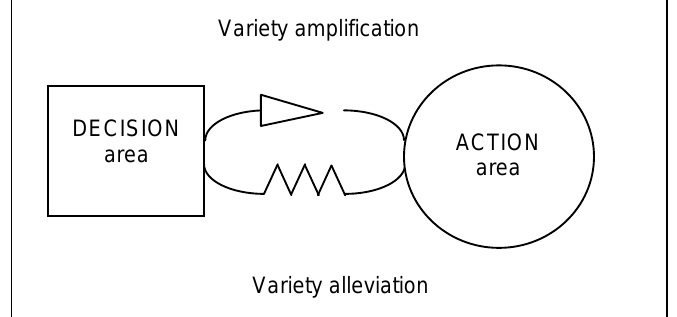
Figure 1: Viable Systems Identities